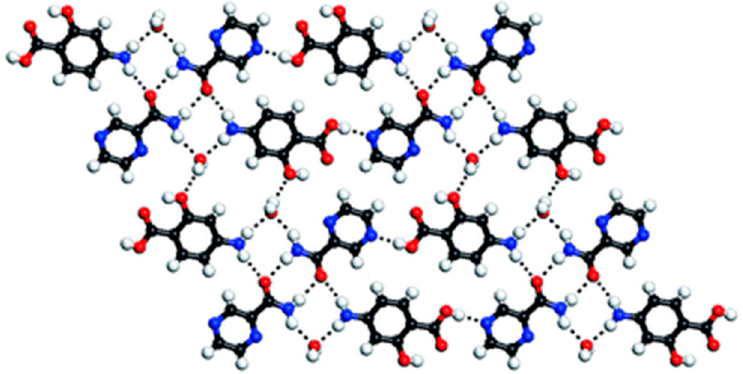
Figure 7. Hydrogen bond interaction present in Pyz-PAS-H 2 O cocrystal. Adapted with permission